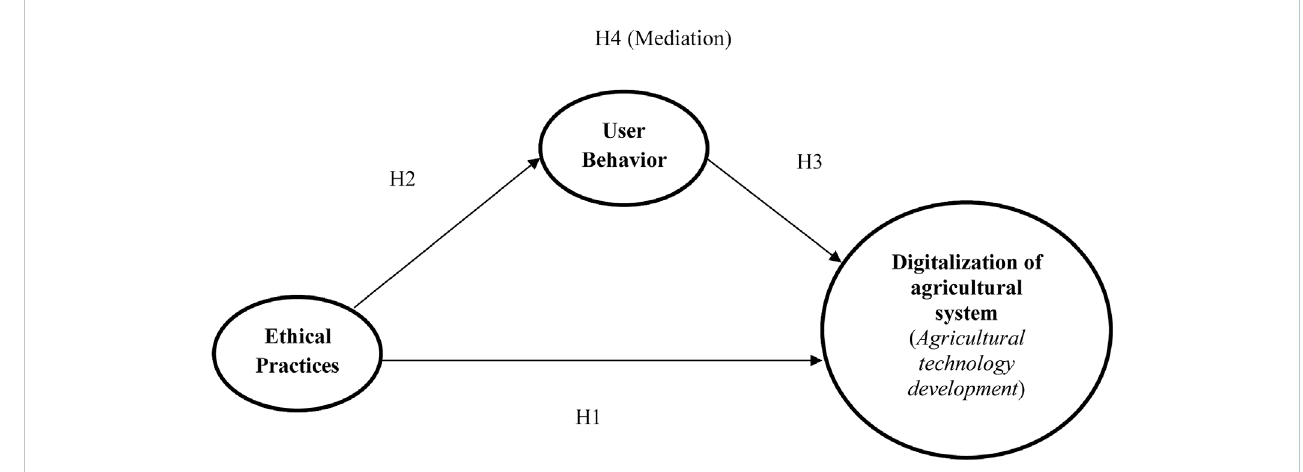
FIGURE 1 Conceptual framework.